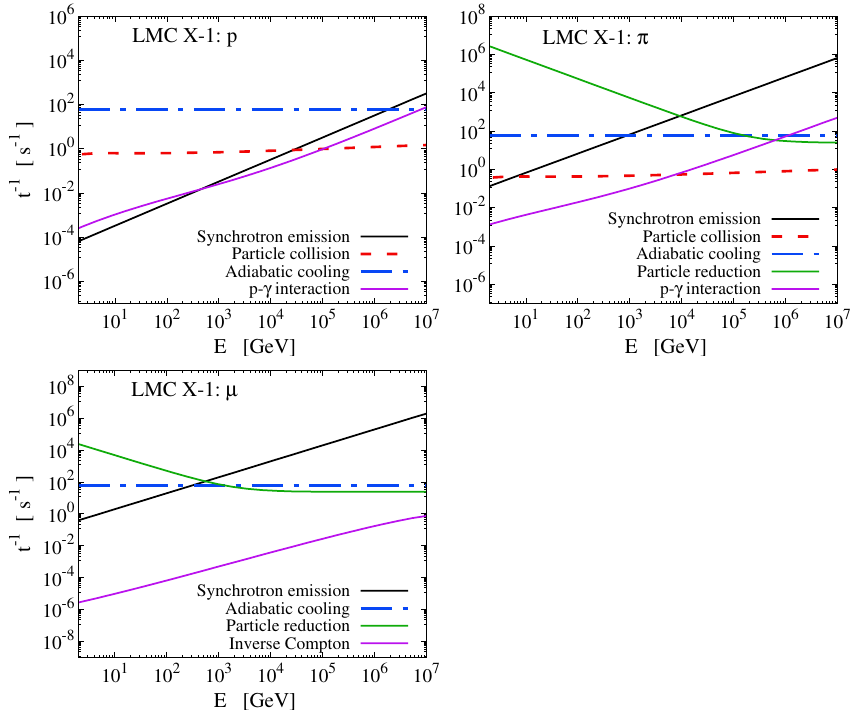
Figure 3. Respective cooling rates for the system of our interest LMC